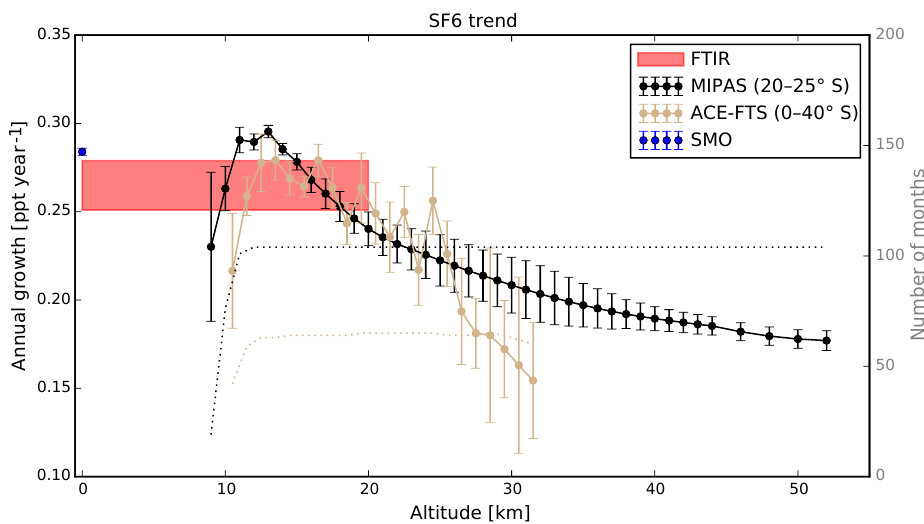
Figure 6. SF 6 annual growths from SMO in situ measurements (2004–2016) (blue bar), ground-based FTIR measurements (2004–2016: combined St Denis and Maïdo)(pink bar), MIPAS measurements (2002–2012) in the latitude band of 20–25 ◦ S for different altitudes (9– 52km) (black solid line) and ACE-FTS measurements (2004–2013) in the latitude band of 0–40 ◦ S for an altitude range of 10.5–32.5km (brown solid line). For MIPAS and ACE-FTS measurements, the dotted line of the same colour is the number of monthly means used for trend analysis at each